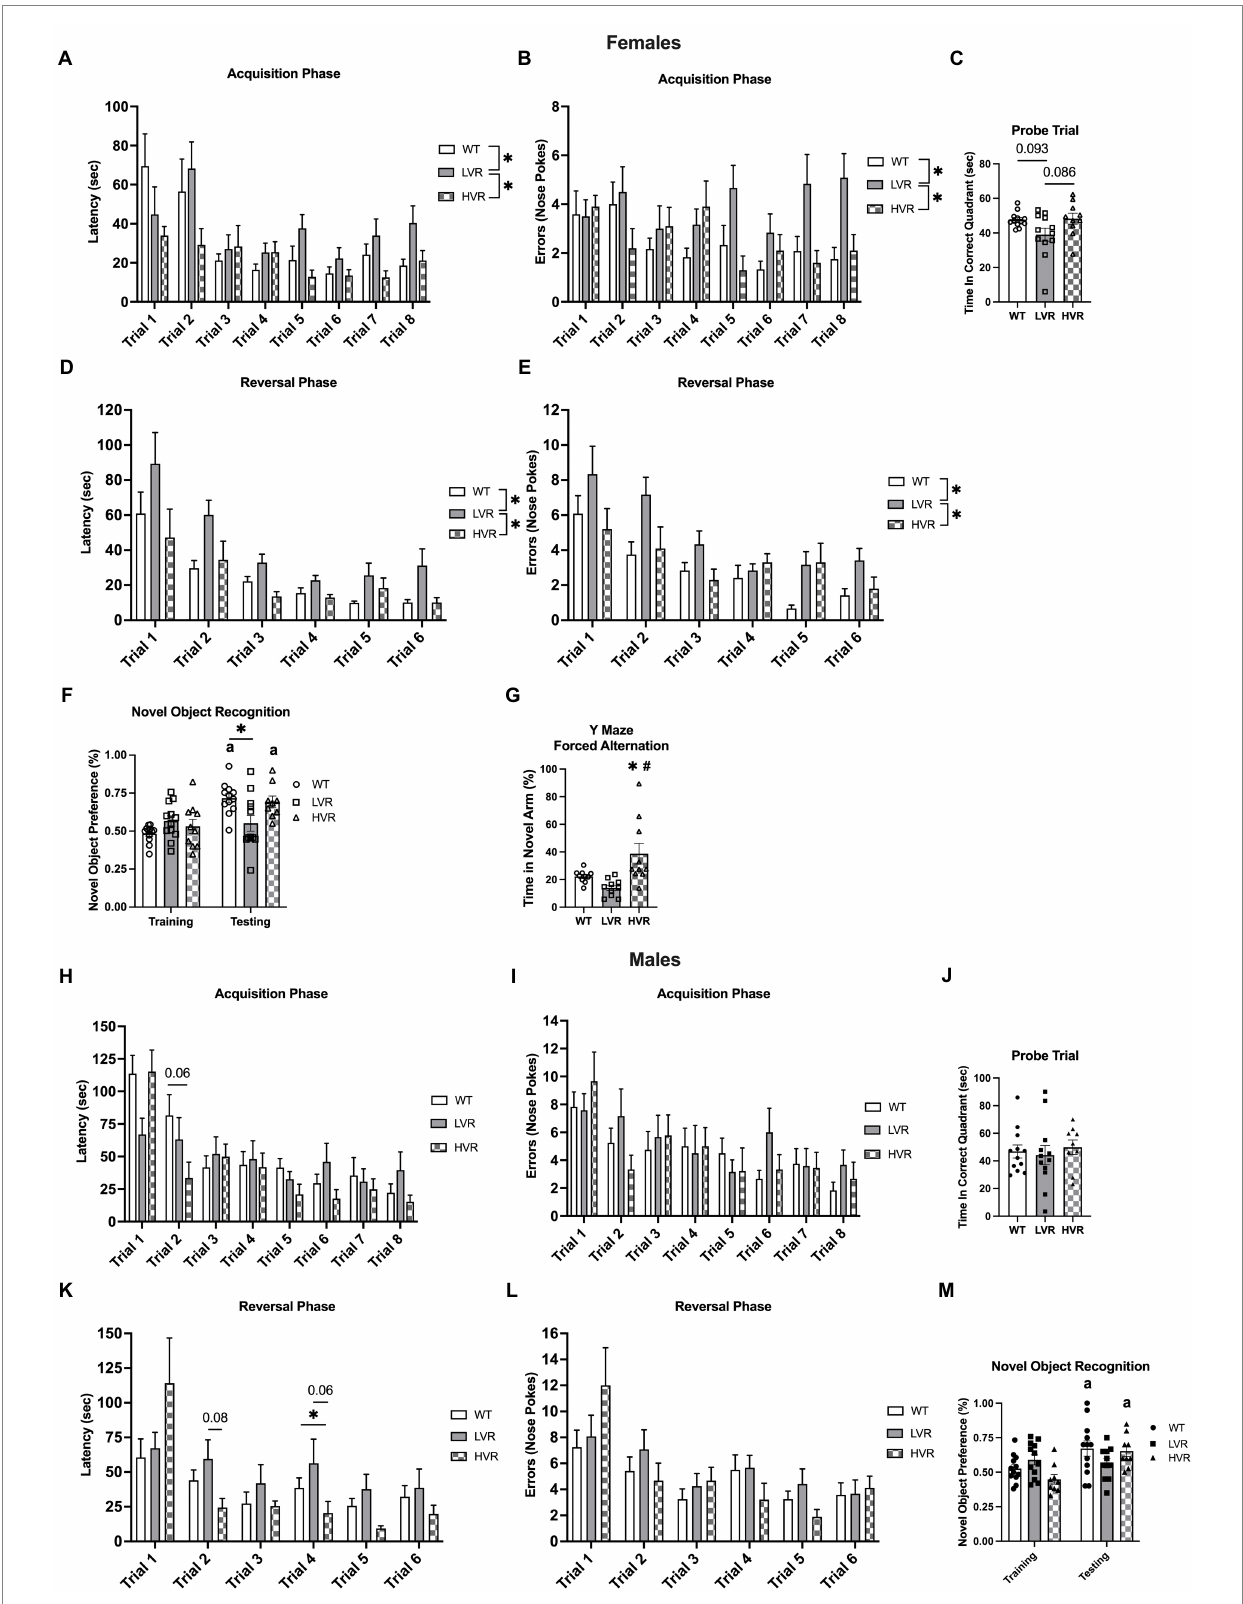
FIGURE 2 Female LVR, but not male LVR, display deficits in spatial learning and memory. Barnes maze acquisition phase (A,B) , probe trial (C) , and reversal phase (D,E) results between female WT (white bars, N = 12), LVR (gray bars, N = 12), and HVR (checkered bars, N = 10). Novel Object Recognition results for female LVR, WT, and HVR (F) . Y-Maze Forced Alternation results for female LVR, WT, and HVR (G) . Barnes maze acquisition phase (H,I) , probe trial (J) , and reversal phase (K,L) results between male WT (white bars, N = 12), LVR (gray bars, N = 12), and HVR (checkered bars, N = 9). Novel Object Recognition results for male LVR, WT, and HVR (M) . * Denotes main effect of group in two-way RM ANOVA or post-hoc difference. a Denotes within group difference between training and testing phase. # Denotes post-hoc difference relative to LVR. Values expressed as mean +